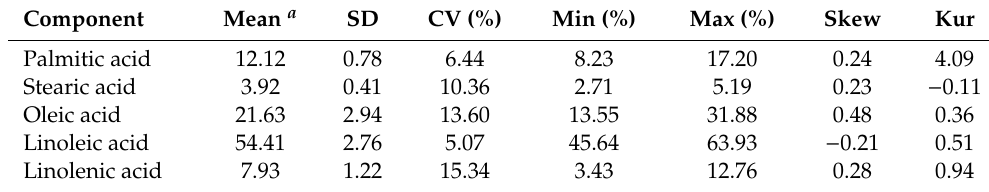
Table 1. Statistical summary of soybean seed fatty acid